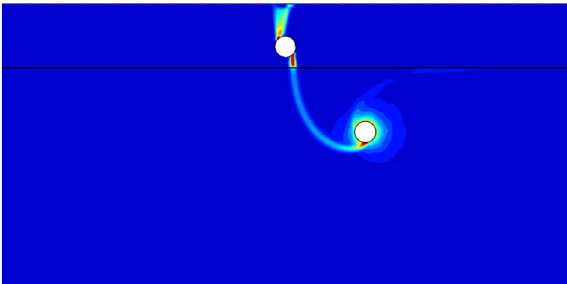
Figure 14. The UB failure mechanism of c u1 / c u2 = 3, X / D = 4, Y / D = 4.